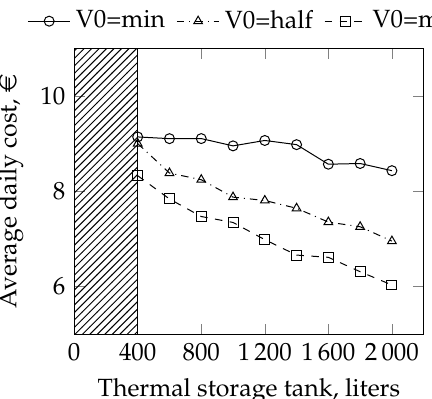
Figure 10. Influence of water tank size on daily cost, for different initial water levels. Climate Zone 5, typical day WSB, battery 2 kWh, operation